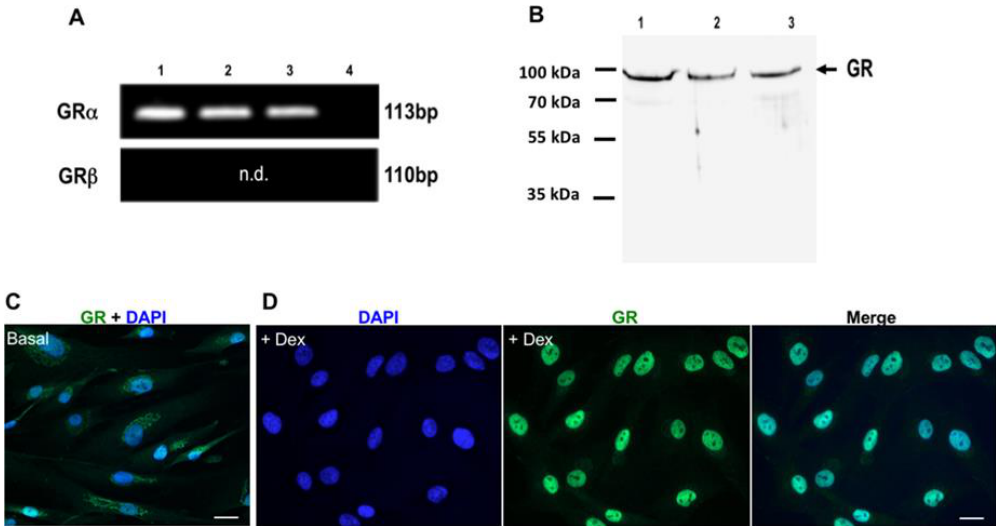
Figure 3. Expression of GR in human testicular peritubular cells (HTPCs). ( A ) Representative RT-PCR products from HTPCs of three different donors (1 – 3). A single band at the expected size of 113 bp is depicted, which upon sequencing was found to correspond to human GRα. Negative control (4) including RNA instead of cDNA shows no band. GRβ is not detected (n.d.) by RT-PCR. ( B ) Western blot of GR was performed with 10 µg of total protein extracted from three different HTPC patient lines (1 – 3), which reveal a band at 95 kDa. The membrane was stripped and re-probed for GAPDH (37 kDa) as loading control (not shown). ( C ) HTPCs grown in DMEM medium were fixed after 1 hour, and the localization of GR was analyzed by immunofluorescence (Basal). Nuclear DNA was stained with DAPI. Under basal conditions, the GR is mainly localized in the cytoplasm, whereas the nuclei are nearly devoid of GR. ( D ) After Dex treatment (1 µM) for 1 hour, GR is identified primarily in the nuclei, indicating translocation of GR after treatment. Scale bars = 10 µm.